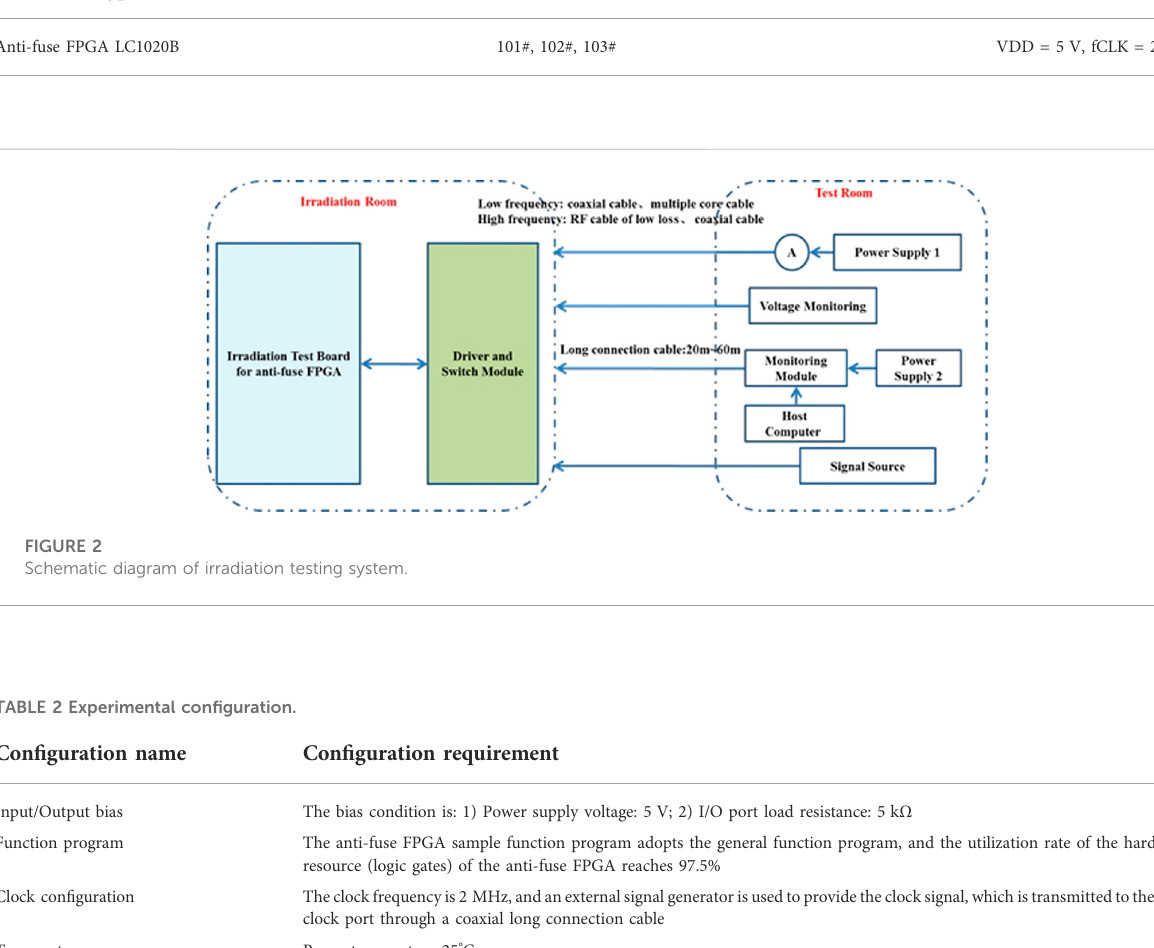
TABLE 1 Total ionizing dose irradiation sample.